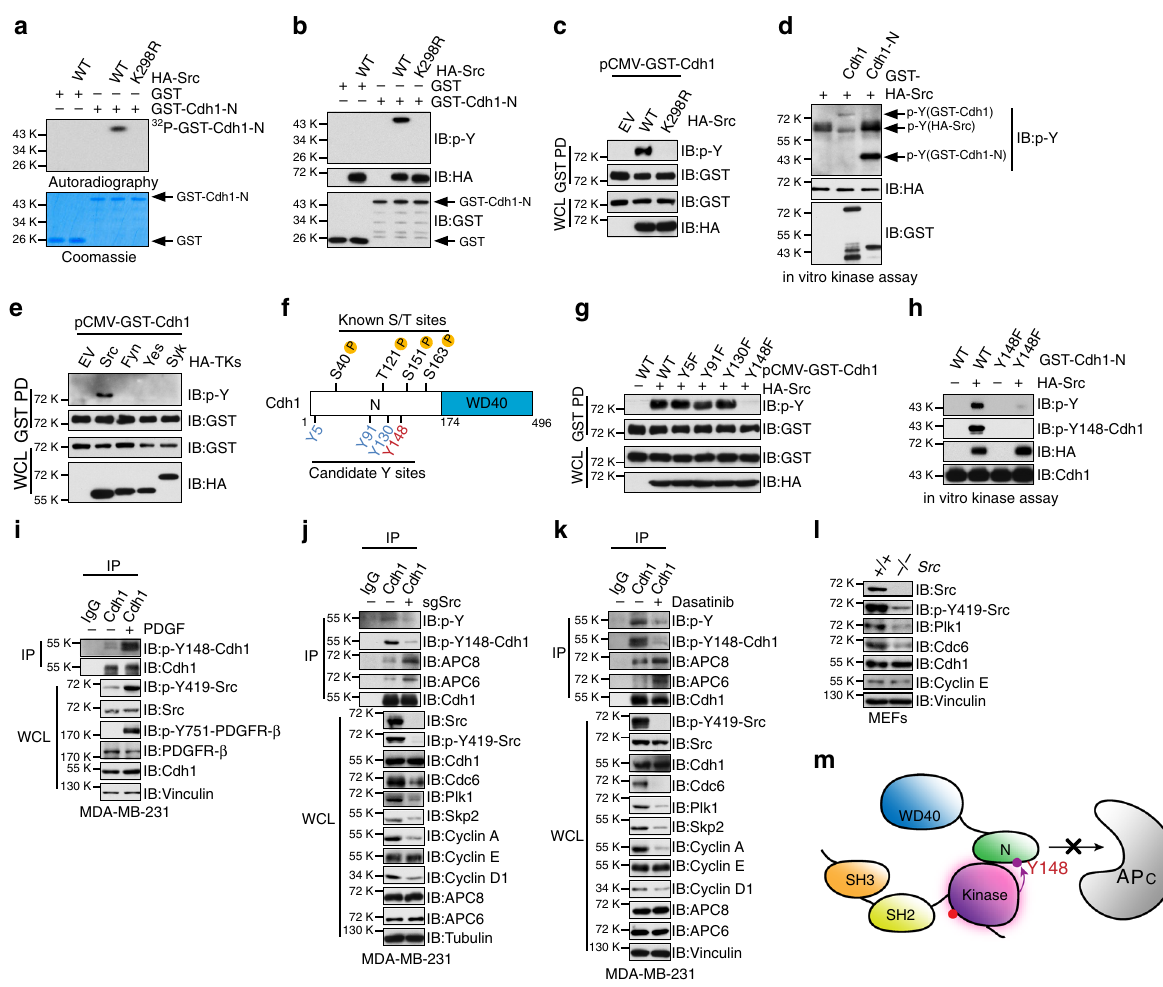
Fig. 6 Src phosphorylates Cdh1 at Y148 to inhibit APC Cdh1 E3 ligase activity. a , b In vitro kinase assays showing that bacterially puri fi ed GST-Cdh1 N - terminus could be phosphorylated by immuno-puri fi ed wild type (WT) Src, but not the enzymatic de fi cient K298R-HA-Src mutant, by autoradiography ( a ) or immunoblot (IB) analysis using the phospho-tyrosine (p-Y) antibody ( b ). c IB analysis of whole-cell lysates (WCL) and GST-pull down precipitates (GST PD) derived from 293T cells transfected with pCMV-GST-Cdh1 and the indicated HA-Src constructs. d In vitro kinase assays showing that immuno- puri fi ed Src kinase phosphorylated both bacterially puri fi ed GST-Cdh1 and its N terminus. e IB analysis of WCL and GST PD derived from 293T cells transfected with pCMV-GST-Cdh1 and the indicated HA-tyrosine kinases (TKs) constructs. f A schematic illustration of the previously identi fi ed phospho- serine/threonine sites as well as the candidate phospho-tyrosine sites of Cdh1 that could be phosphorylated by the Src kinase. g IB analysis of WCL and GST PD derived from 293T cells transfected with HA-Src and the indicated pCMV-GST-Cdh1 constructs. h In vitro kinase assays showing that immuno- puri fi ed WT-HA-Src failed to promote the phosphorylation of bacterially puri fi ed Y148F mutated-GST-Cdh1 N -terminus. i IB analysis of WCL derived from MDA-MB-231 cells that were treated with 4 ng ml − 1 PDGF for 30 min as indicated. Cells were serum-starved overnight before treatment. j IB analysis of WCL and anti-Cdh1 IP derived from control or sg Src -infected MDA-MB-231 cells. Cells were pretreated with 4 ng ml − 1 PDGF for 30 min before harvest. k IB analysis of WCL and anti-Cdh1 IP derived from DMSO or dasatinib-treated MDA-MB-231 cells. Cells were pretreated with 4 ng ml − 1 PDGF for 30 min before harvest. l IB analysis of WCL derived from WT and Src − / − MEFs. m A schematic illustration of phosphorylation of Cdh1 at Y148 by Src disrupts the binding between Cdh1 N terminus and the APC core